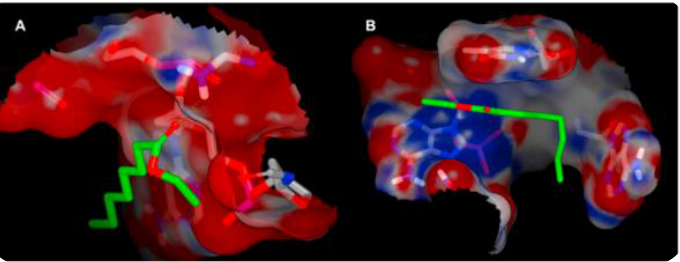
Figure 6. Electrostatic molecular surfaces of the ssDNA CTGCAA, with a planar interaction surface (binding score –2.26 k/mol) ( A ), and ATAATC with a saddle shaped binding pocket (binding score –6.28 k/mol) ( B ) in complex with ethyl octanoate (highlighted in green)